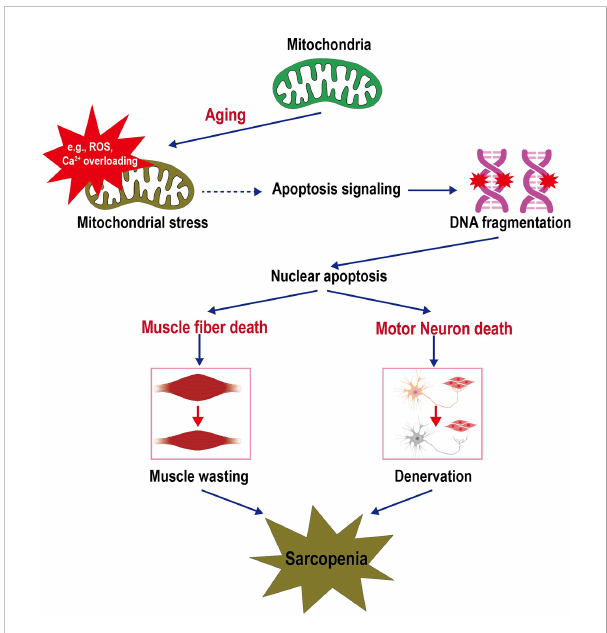
FIGURE 1 Schematic depicting the sarcopenia triggered by mitochondrial stress in aging. Increased mitochondrial stresses in the aging lead to mPTP opening. The release of mitochondrial contents (e.g., ROS, Ca 2+ , and cytochrome c) into the cell cytosol initiates an apoptotic signaling cascade that culminates in DNA fragmentation and loss of the nucleus (apoptosis). Suf fi cient nuclear death in a muscle cell will result in the death and removal of the entire muscle cell. Furthermore, motor neuron death coincides with skeletal muscle cell death, i.e., the apoptotic removal of alpha motor neuron nuclei. The death of these cells contributes to the loss of muscle mass and function during aging. Thus, dysfunctional mitochondria trigger a cascade of signals that initiate the signaling pathways that lead to